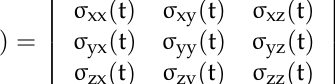
Figure 9. Comparison of fracture location in an experiment with area detection by FEM presented in this study [55].